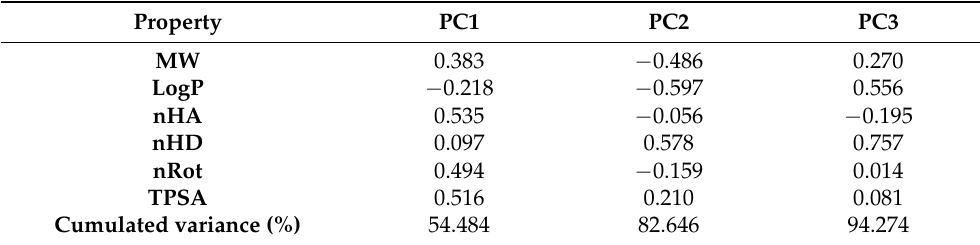
Table 2. Compositions of the top three principal components in terms of the six properties and the accumulated